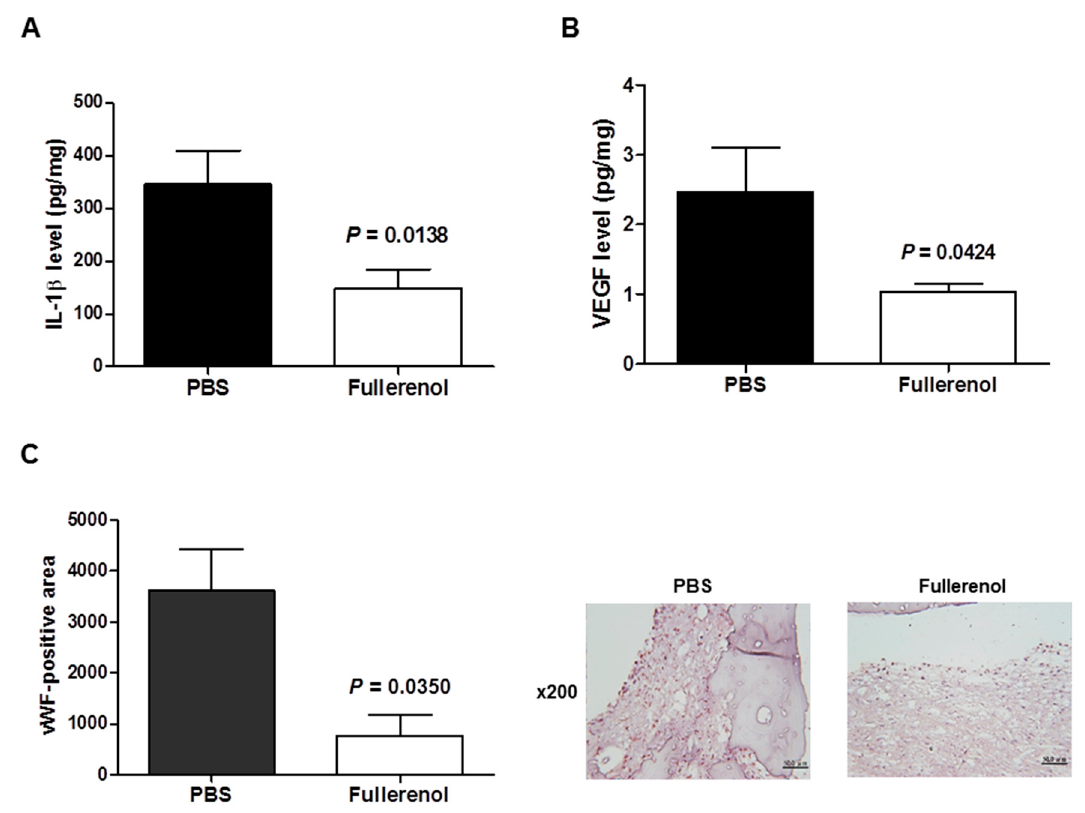
Figure 6. Amelioration of CIA by suppressing pro-inflammatory cytokine production and the angiogenesis process. ( A ) Interleukin (IL)-1 β concentrations in joint extracts obtained from fullerenol- and PBS-injected CIA joints. ( B ) Vascular endothelial growth factor (VEGF) concentrations in joint extracts obtained from fullerenol- and PBS-injected CIA joints. ( C ) von Willebrand factor (vWF)-stained areas in synovial tissues obtained from fullerenol- and PBS-injected CIA joints, with representative immunohistochemical staining. The values are the mean ± standard error of 8 joints per group in ( A , B ), and 5 joints per group in ( C ). Bars represent 50 µ m at 200 ×.